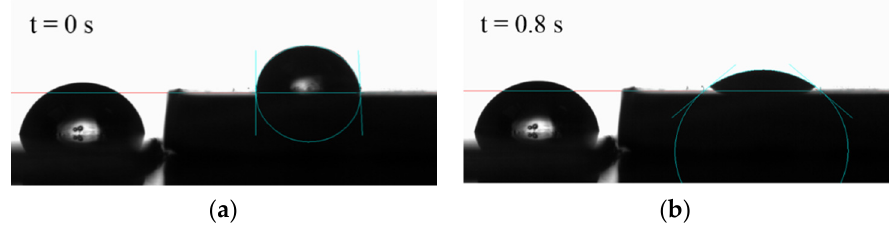
Figure 2. Images of two 10 µL water drops on a hydrophobic polycarbonate (left) as a reference, and the hydrophilic Al 2 O 3 ceramic for different times: ( a ) a snapshot of the first water ceramic contact (t = 0 s); ( b ) the drops after approximately 0.8 s. After approximately 1.6 s, the drop on the ceramic was fully absorbed.